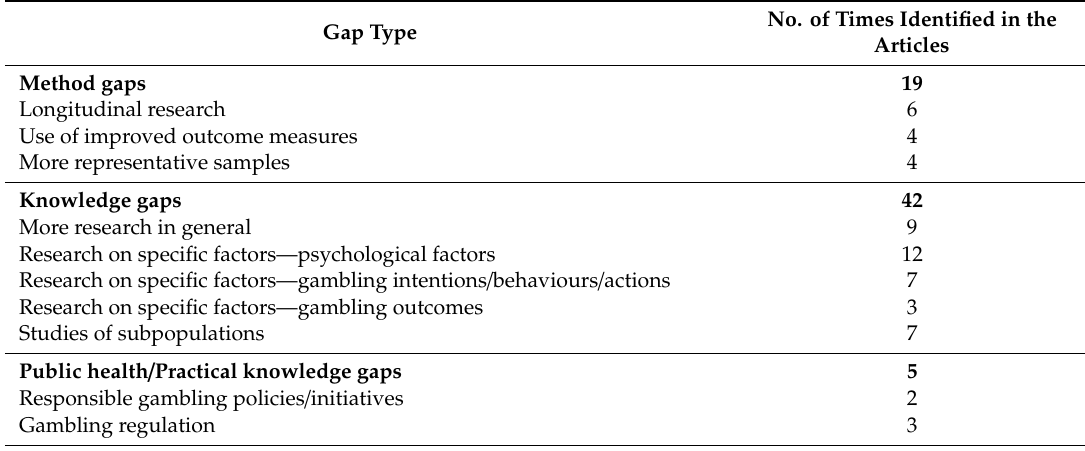
Table 4. Internet gambling